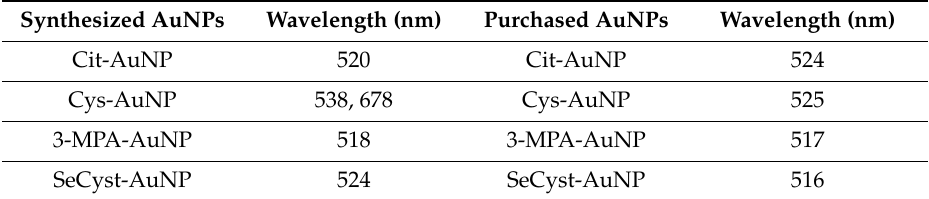
Table 2. Comparison of the SPR band λ max values of synthesized and purchased AuNPs stabilized by citrate and functionalized with Cys, 3-MPA and SeCyst, respectively at pH of approximately